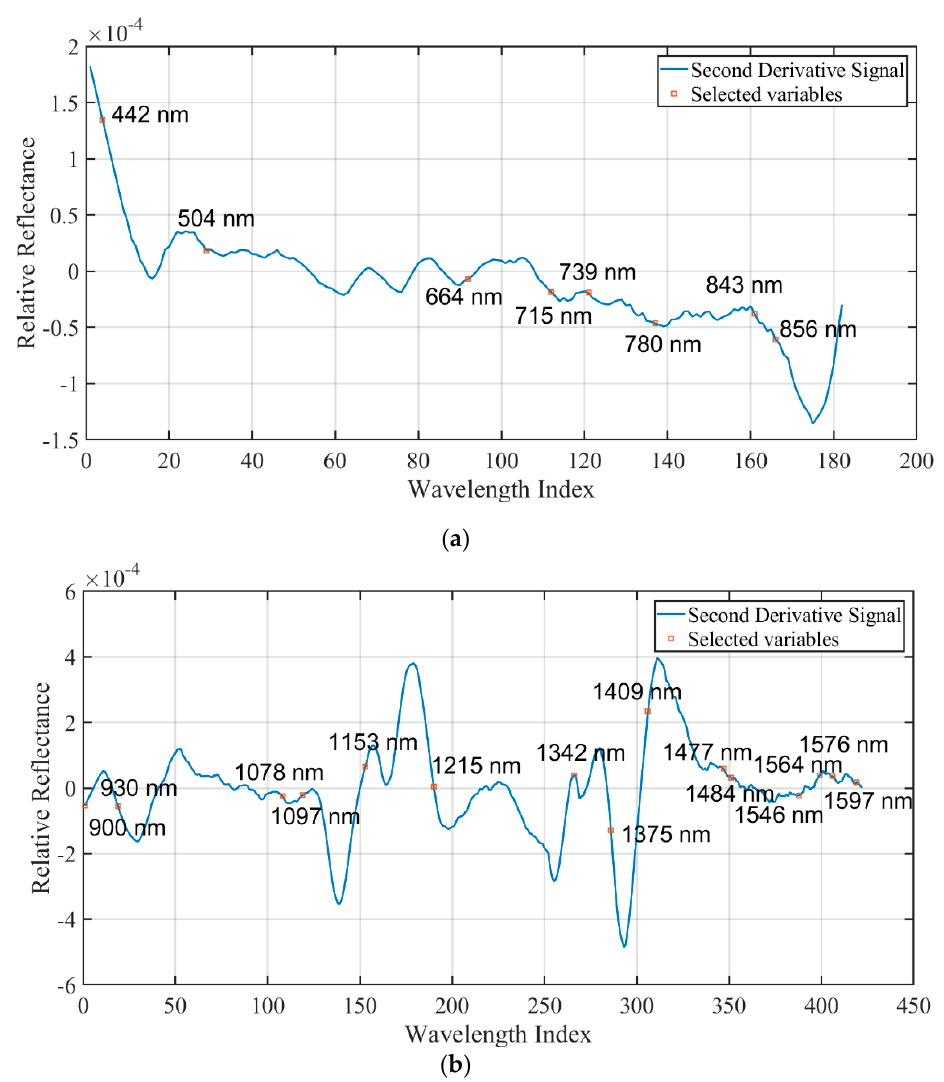
Figure 5. Effective wavelengths extracted from the VNIR range (435–898 nm) ( a ) and the SWIR range (900–1601 nm) ( b ) using successive projection algorithm (SPA) based on the calibration set.